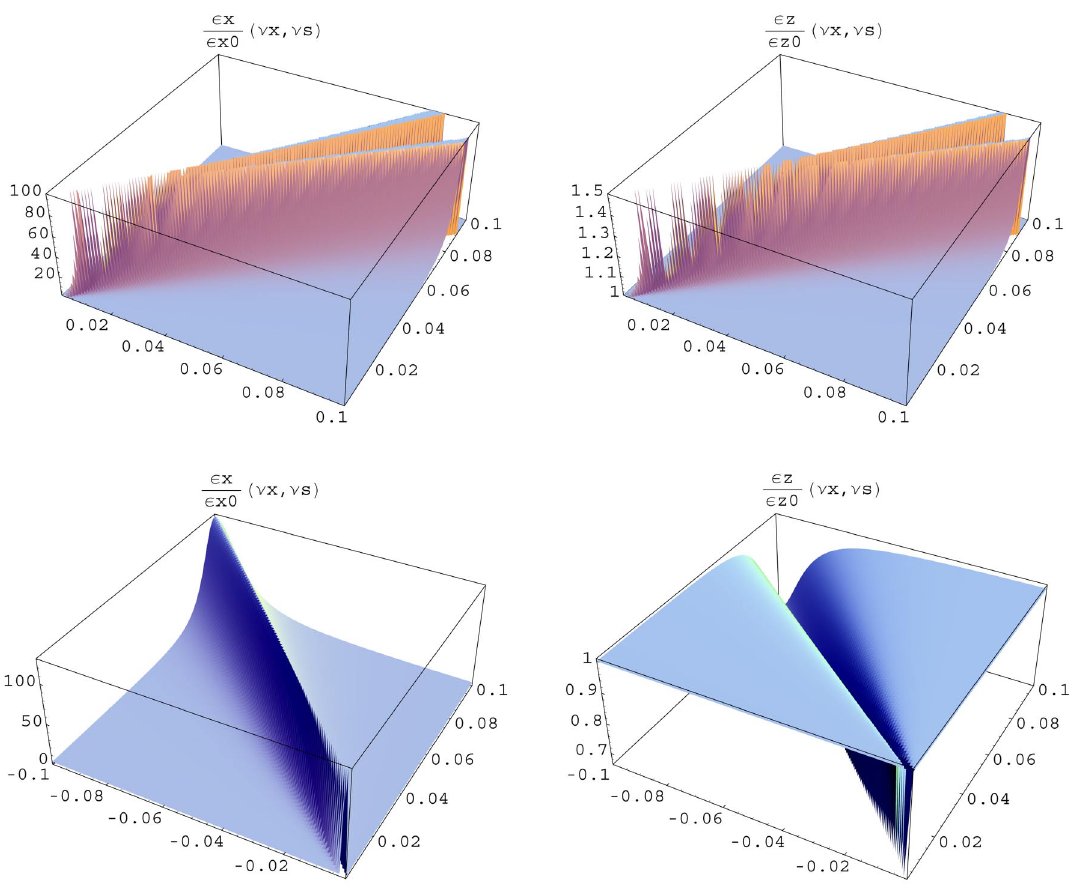
FIG. 5. (Color) 3D plots of projected emittances near the sum and difference resonances due to a dispersive rf cavity. The four plots have the same meanings as in Fig. 3. The parameters are the same as those in Figs.